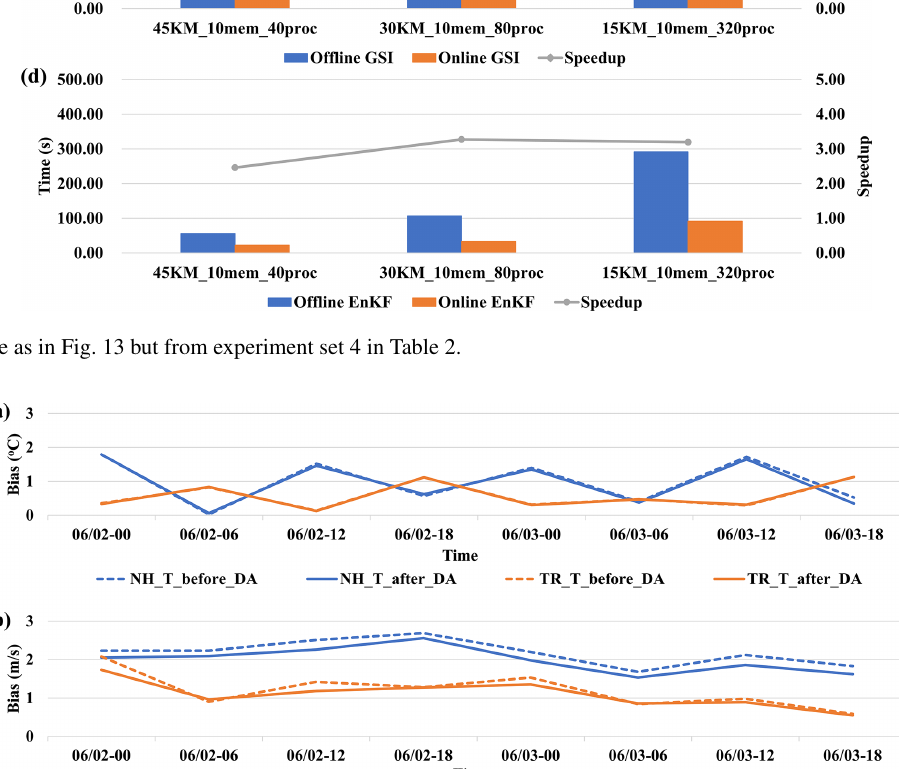
Figure 17. Total bias of assimilated variables relative to corresponding observations before and after DA for (a) T and (b) UV at each DA time from the EnKF standard output file. The dotted lines indicate the bias of assimilated variables before DA, and the solid lines indicate the bias of assimilated variables after DA. Blue lines are the bias in the area of 0–25 ◦ N, and orange lines are the bias in the area of 25–50 ◦